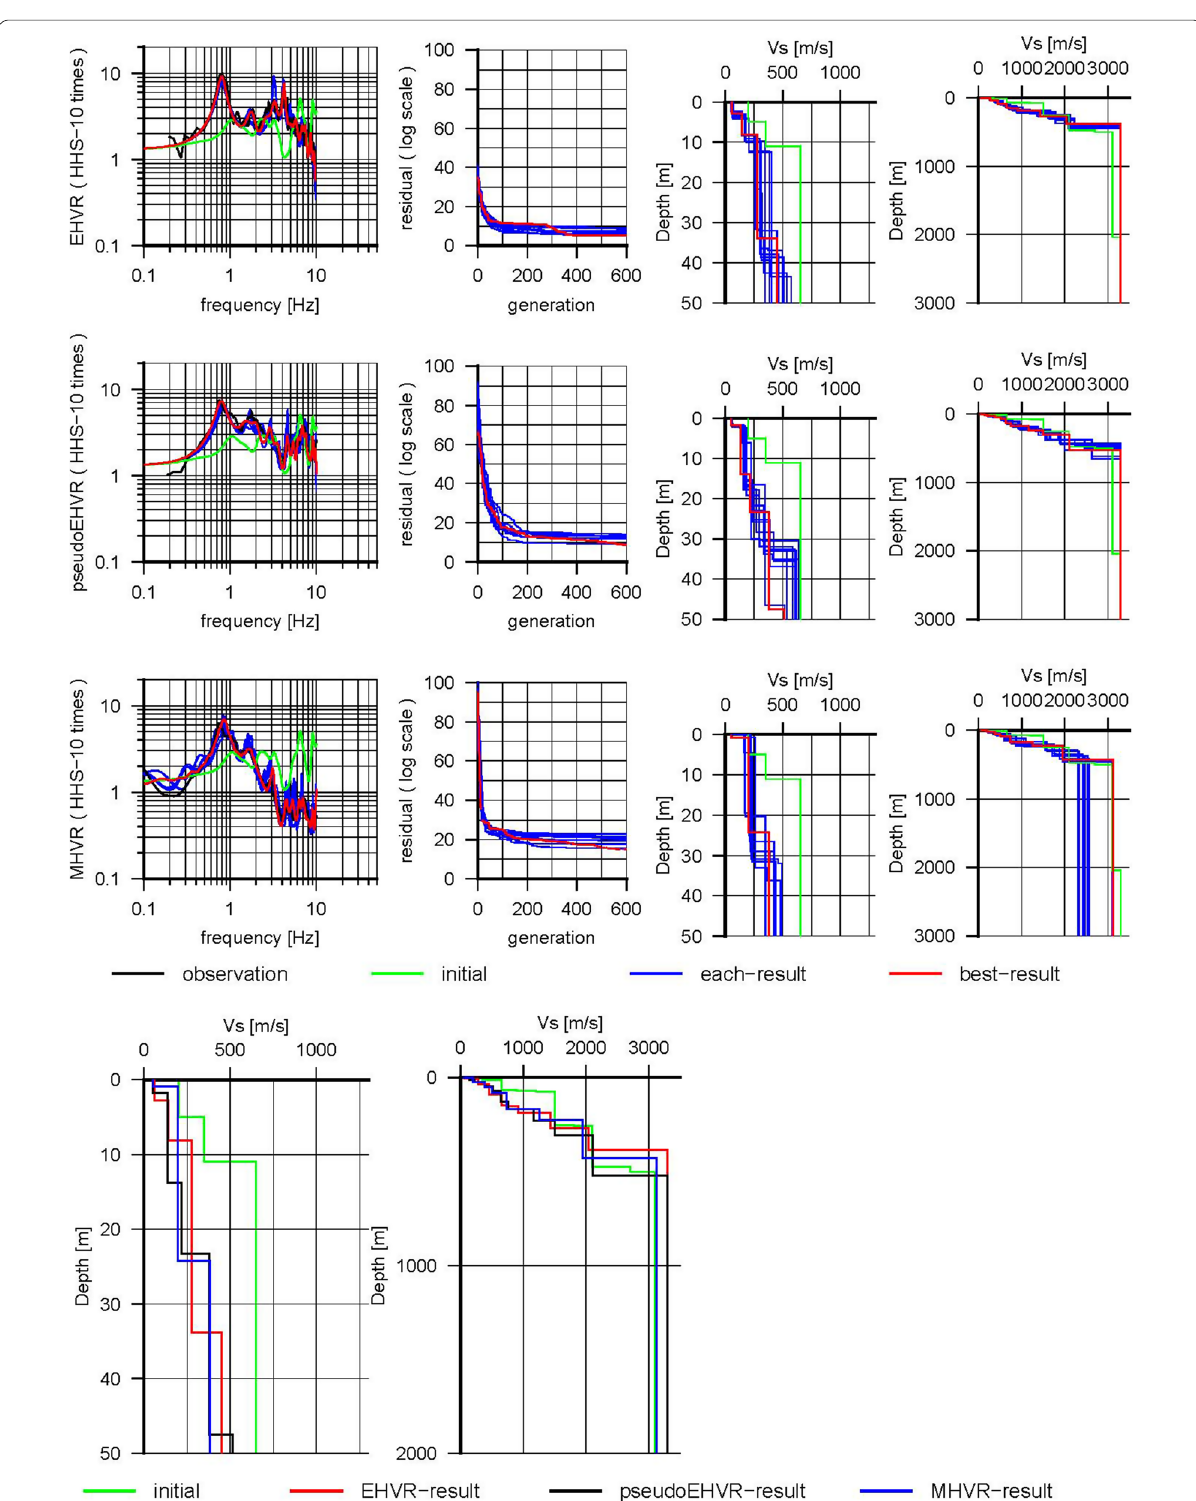
Fig. 23 Inversion results at TRMA when an underground structure model based only on the J-SHIS information is used (i.e., no constraint in the shallow